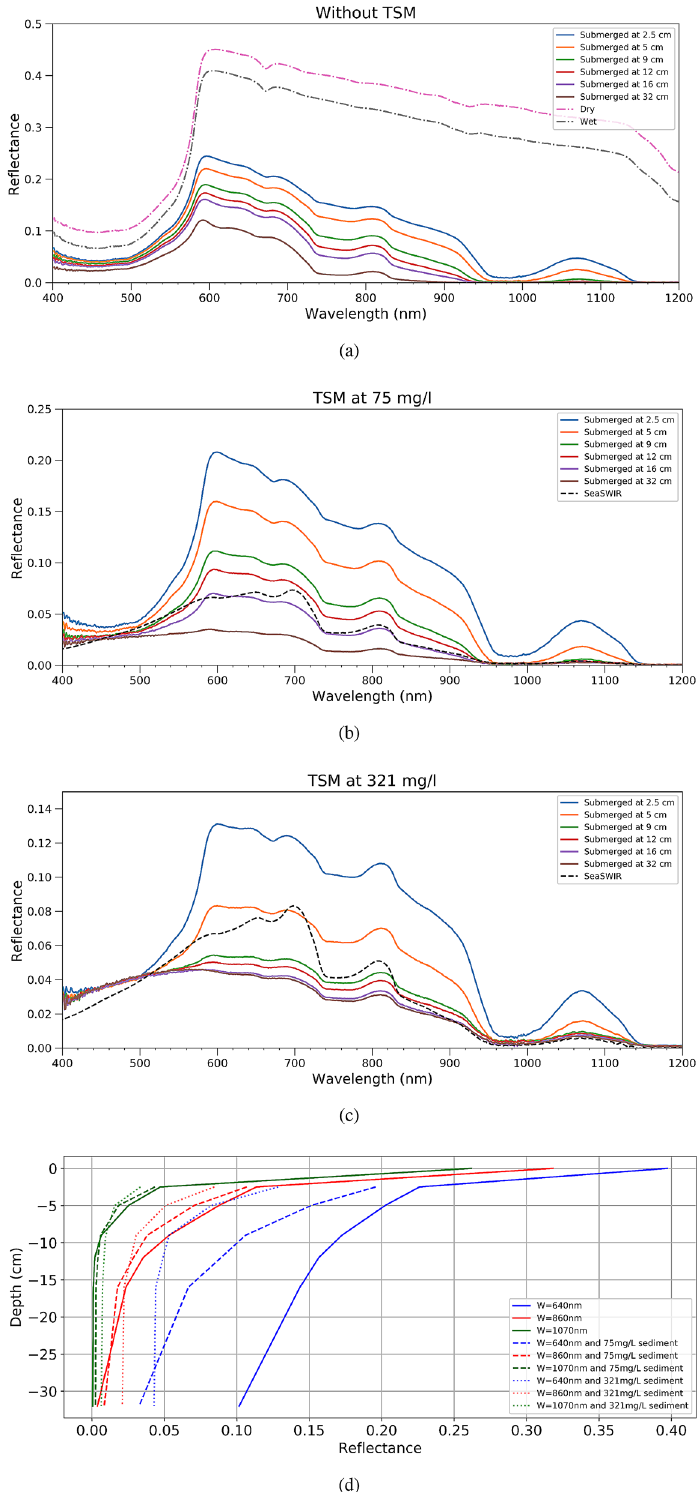
Figure 5. Above water reflectance when submerging an orange rope at different depths in the tank in three conditions: ( a ) without sediment, ( b ) TSM concentration of 75 mg/l and ( c ) TSM concentration of 321 mg/l. A SeaSWIR water spectrum with similar TSM concentration is added. ( d ) Above water reflectance at specific wavelengths for an orange placemat at different